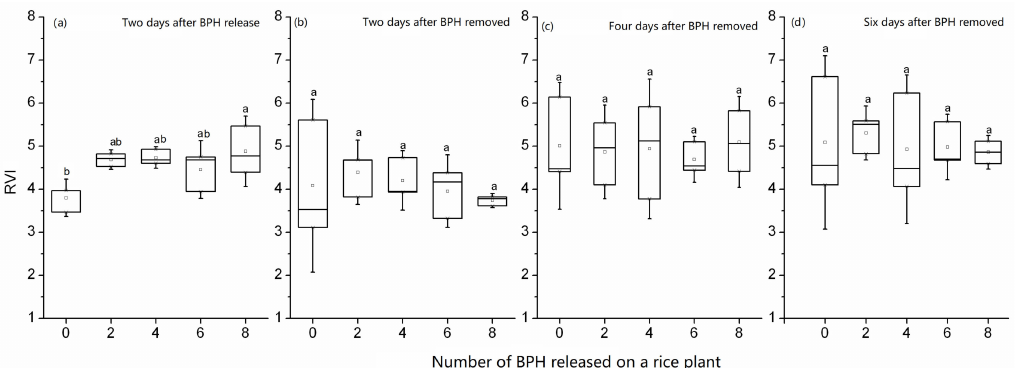
Figure 3. RVI 746/670 of rice leaves exposed to 0–8 second-instar nymphs of BPH in two days ( a ) and 2–6 days after BPH exposure ( b , c and d ). In the box plot, the box represents the 25th and 75th percentiles; whiskers represent the minimum and maximum values; the line in box represents the median percentile; the open circle in a box represents the mean. The different letters above the box plots show significant differences in the RVI 746/670 means among different numbers of BPH at p = 0.05 level.